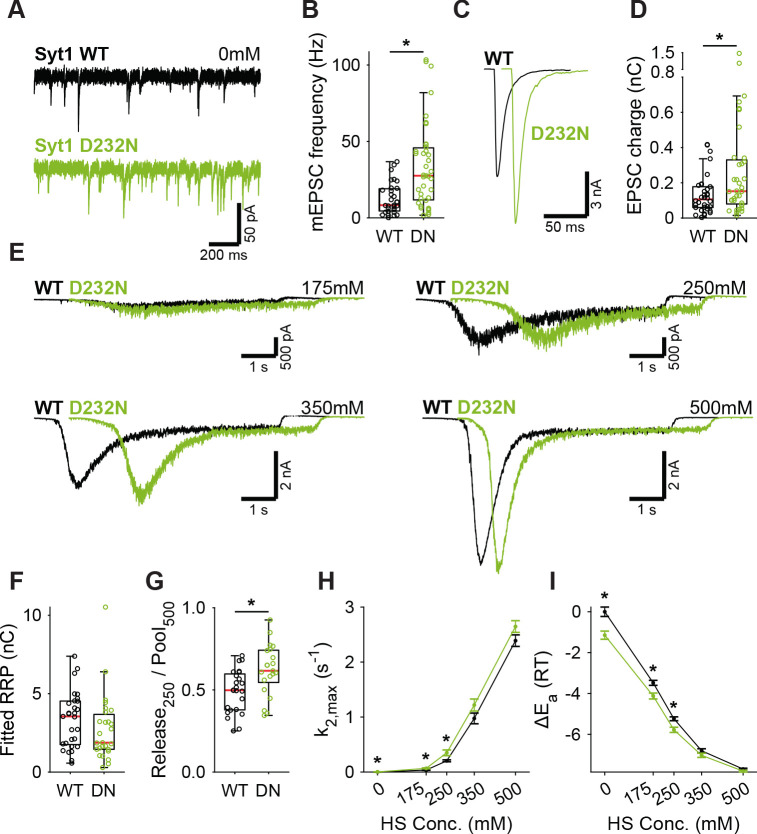
A decreased energy barrier increases vesicle fusion in Syt1 D232N expressing synapses.(A) Representative traces of spontaneous release (0 mM HS), and (B) boxplot of spontaneous frequency in Syt1 WT and Syt1 D232N expressing synapses. (C) Representative traces of AP-evoked release in Syt1 WT and Syt1 D232N, overlaid with 20 ms offset, and (D) boxplot of charge transferred during the first evoked EPSC. (E) Representative traces of HS-induced release in Syt1 WT and Syt1 D232N, overlaid with 1 s offset, at 175 mM, 250 mM, 350 mM, and 500 mM HS, and boxplots of (F) RRP charge estimated from 500 mM HS, (G) depleted RRP fraction at 250 mM HS in Syt1 WT and Syt1 D232N. (H) Plots (mean ± S.E.M.) of maximal HS release rates, and (I) change in the fusion energy barrier at different HS concentrations for Syt1 WT and Syt1 D232N. (*p<0.05, Wilcoxon rank sum test).
Figure 3—source data 1.Statistics overview.